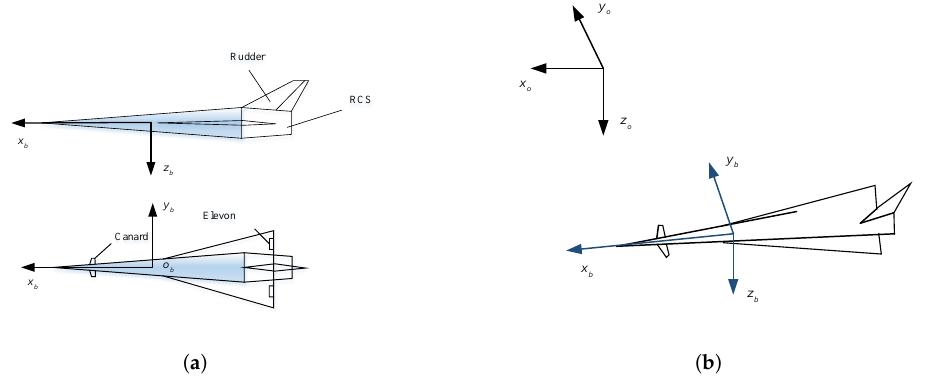
Figure 2. ( a ) Schematic drawing of NSHV; ( b ) the inertia and body coordinate.